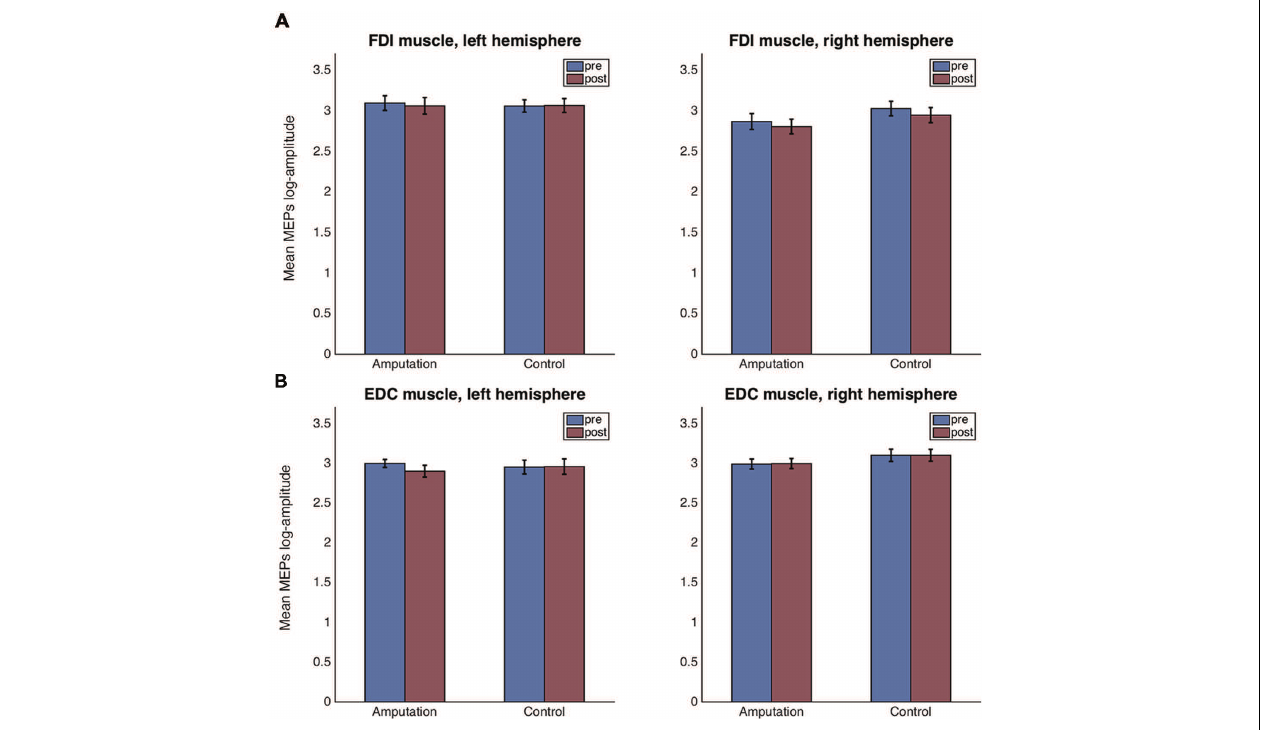
FIGURE 4 | Mean and standard error plots for the log-transformed MEP amplitudes per hemisphere, time and condition for the FDI muscle (A) and for the EDC muscle